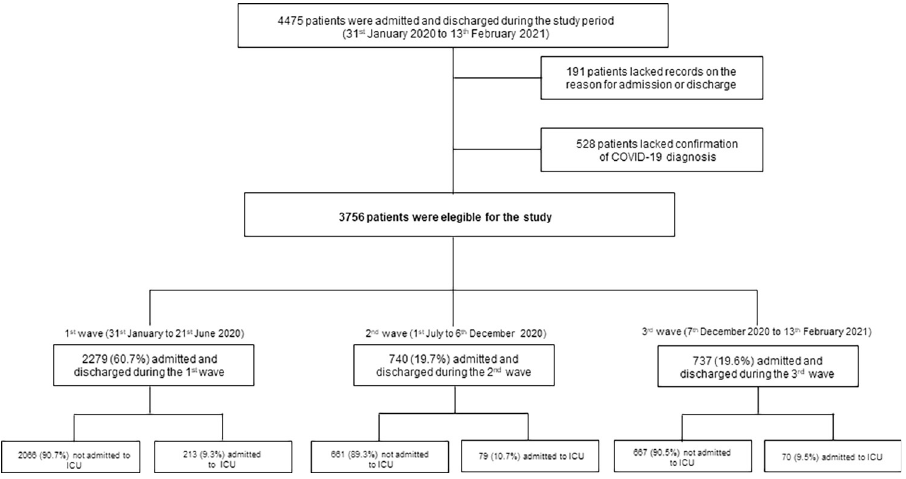
Fig 1. Flow chart of the study cohort. Abbreviations: COVID-19 (coronavirus disease-2019); ICU (intensive care unit).